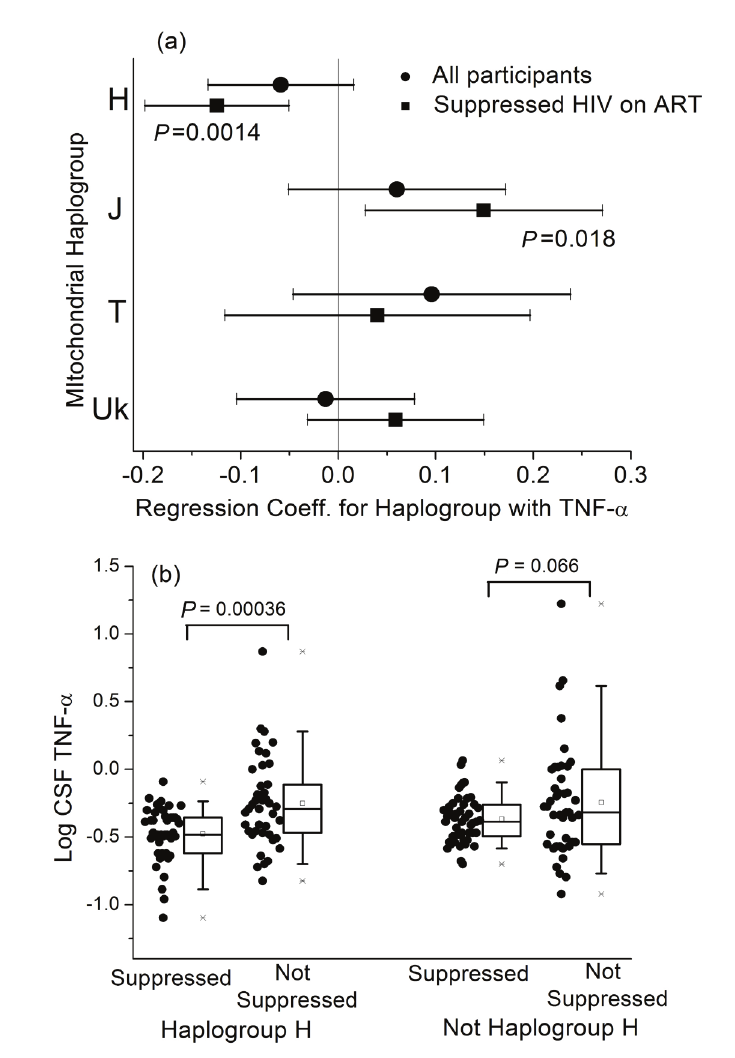
Figure 1. (A) Coefficients from the adjusted linear regression for log CSF TNF-α for the 4 European haplogroups tested. Results are shown for all participants (N = 174), and for the subset of patients on ART with HIV RNA levels ≤ 50 copies/mL (N = 90). P values are given for statistically significant regressions. (B) Univariate comparison of log CSF TNF-α values for Caucasian participants from Haplogroup H com- paring participants with suppressed virus (plasma HIV RNA ≤ 50 copies/mL on ART) to nonsuppressed participants, and the same comparison in all other